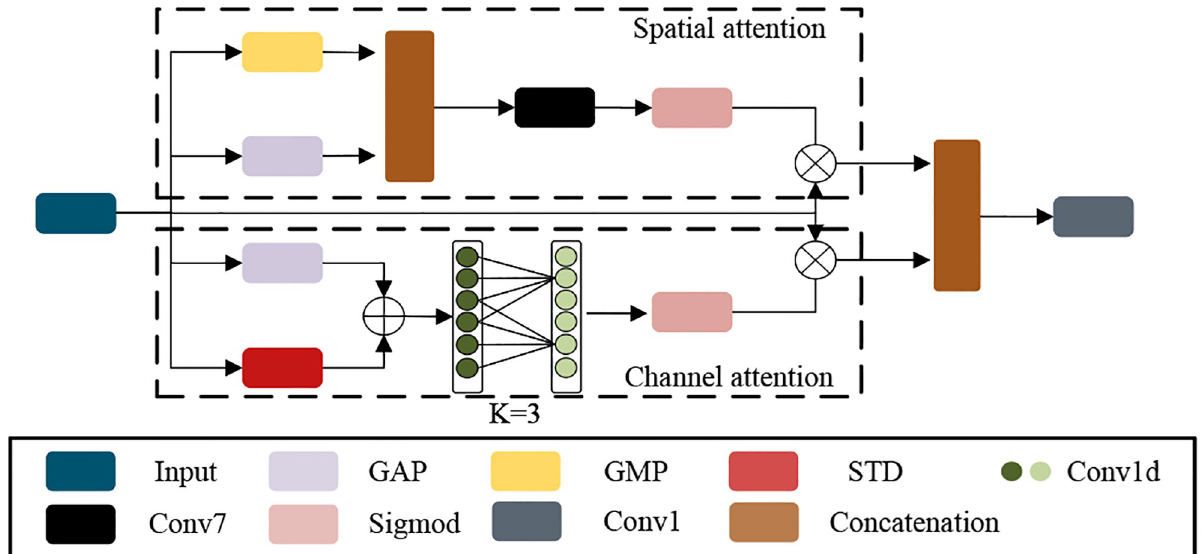
Fig 3. The structure of our proposed dual attention. Conv1d is a 1-Dimension convolution. We set the kernel of Conv1d as 3. � is element-wise multiplication operation.